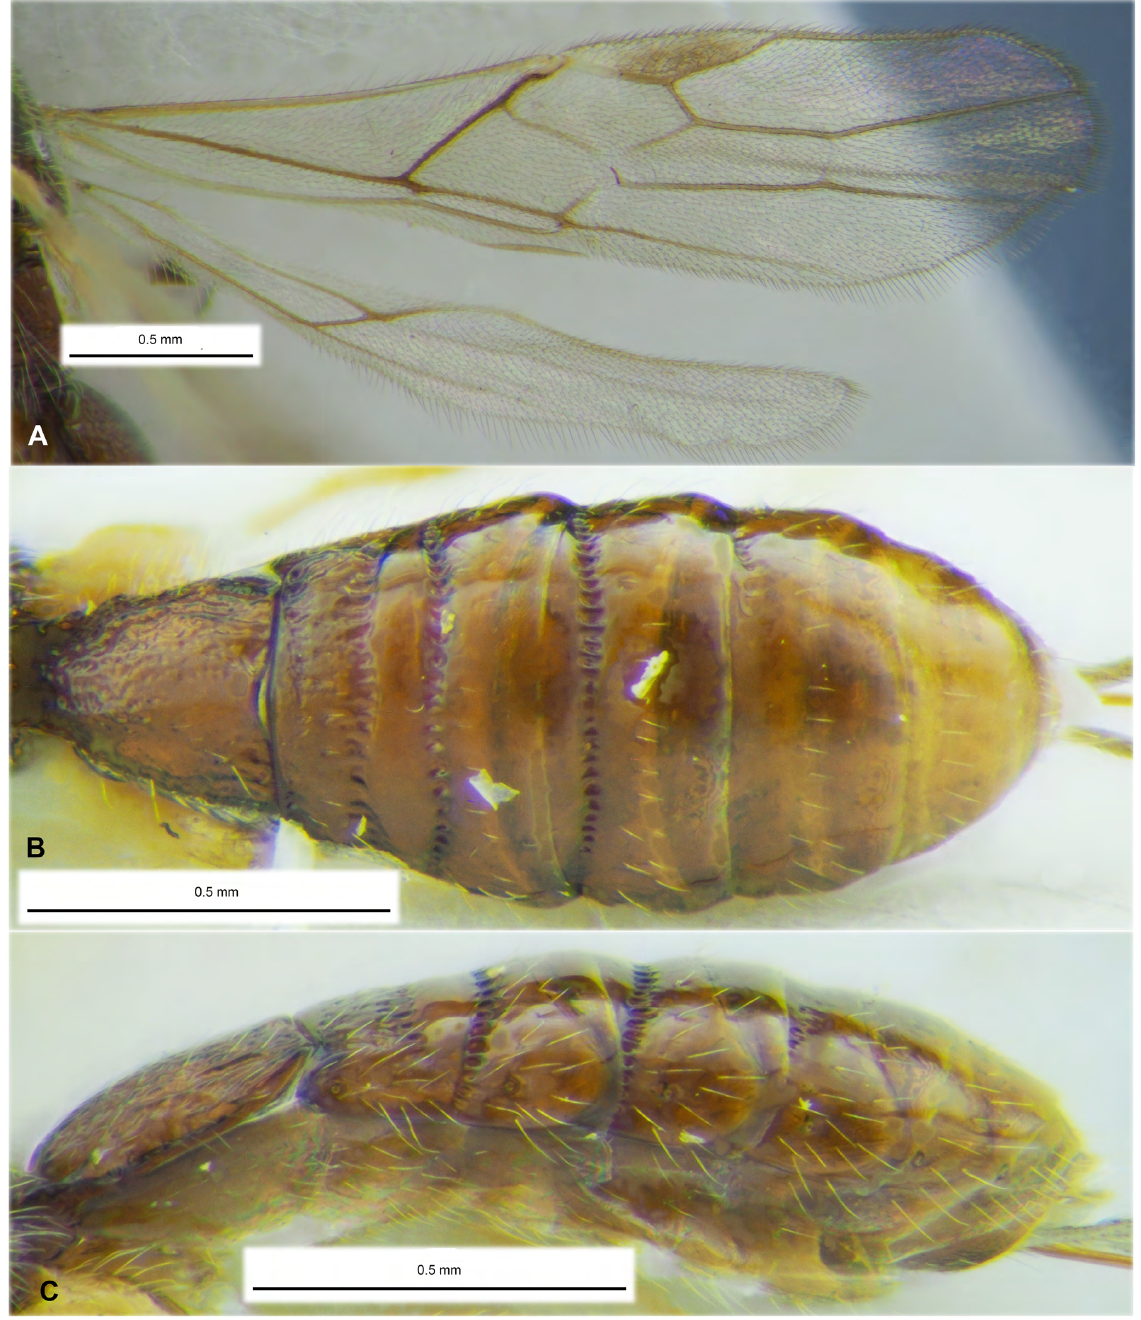
Fig. 21. Ipodoryctes ( Afroipodoryctes ) saintphilippensis sp. nov., ♀, holotype, MNHM. A . Wings. B . Metasoma, dorsal view. C . Metasoma, lateral